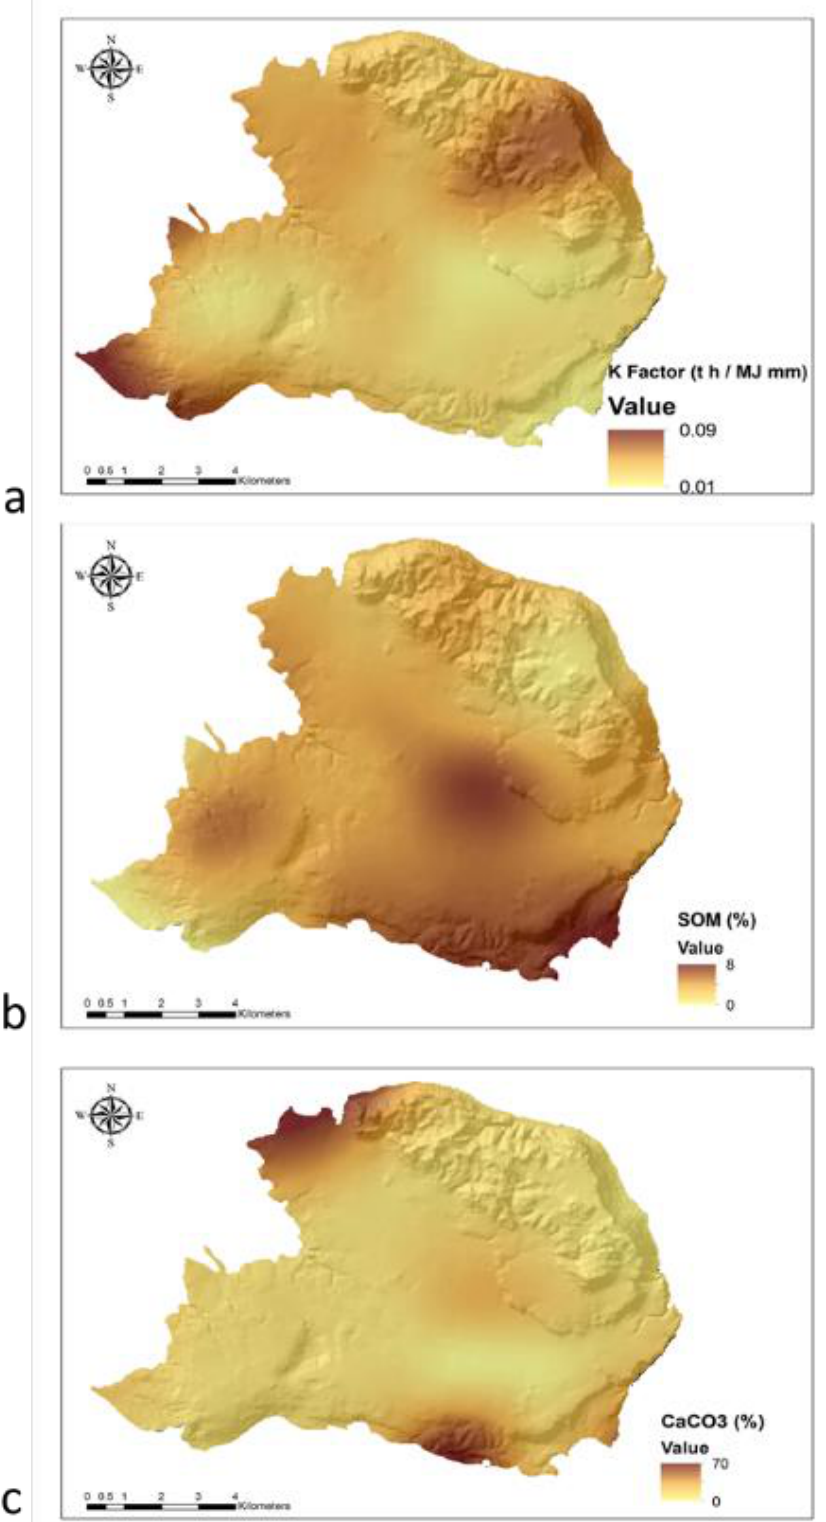
Figure 6. ( a ) Soil erodibility (K-factor), ( b ) SOM, and ( c ) CaCO 3 spatial distribution in the study